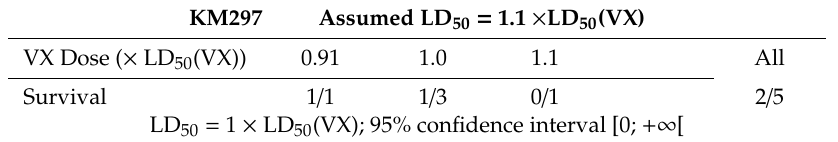
Table 6. LD 50 estimation using the up-and-down method for intraperitoneally injected mice at the dose of 10 mg / kg (i.e., 23.3 µ mol / kg) of KM297 free base one minute after VX subcutaneous challenge.